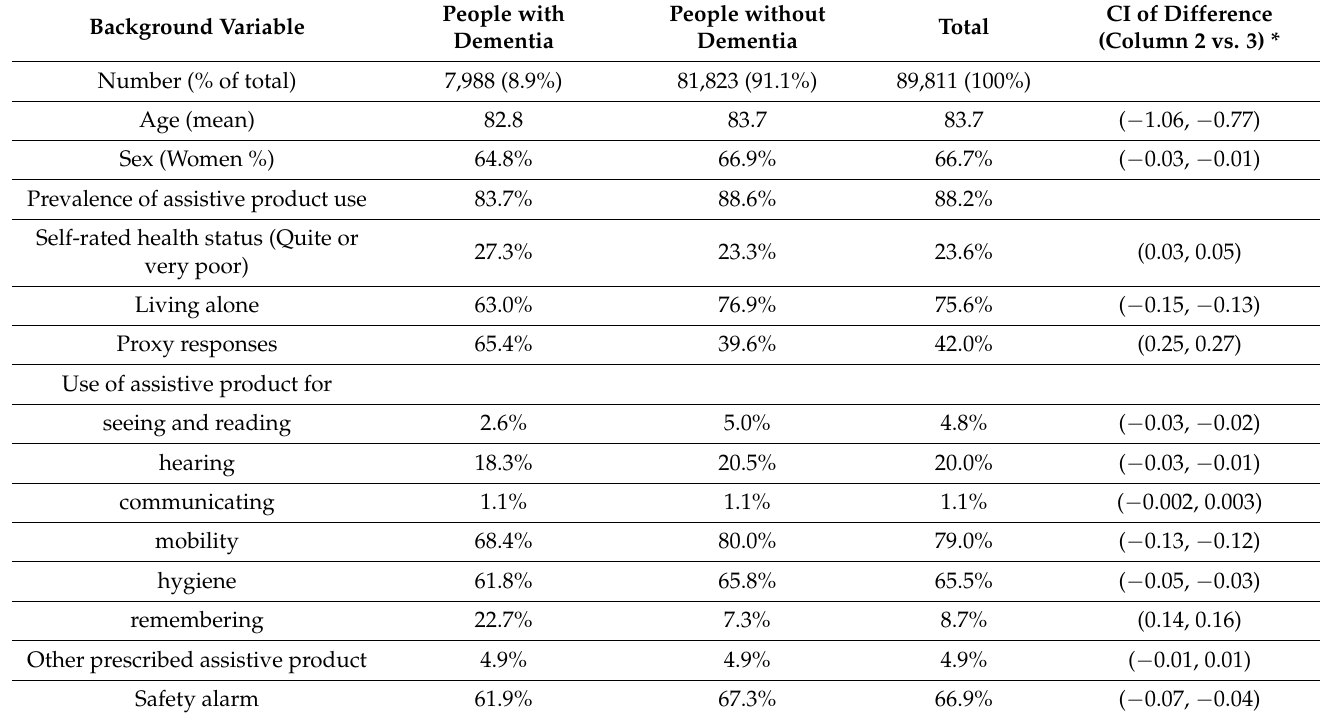
Table 2. Comparative background characteristics of the respondents with and without